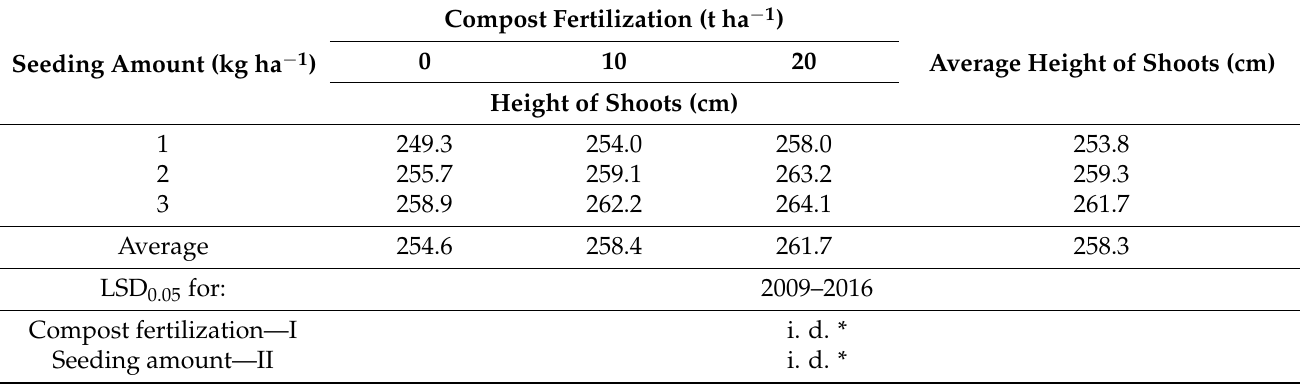
Table 5. Effects of seeding amount and fertilization with compost on the average height of the Sida shoots (cm) during the years of full use (2010–2016).